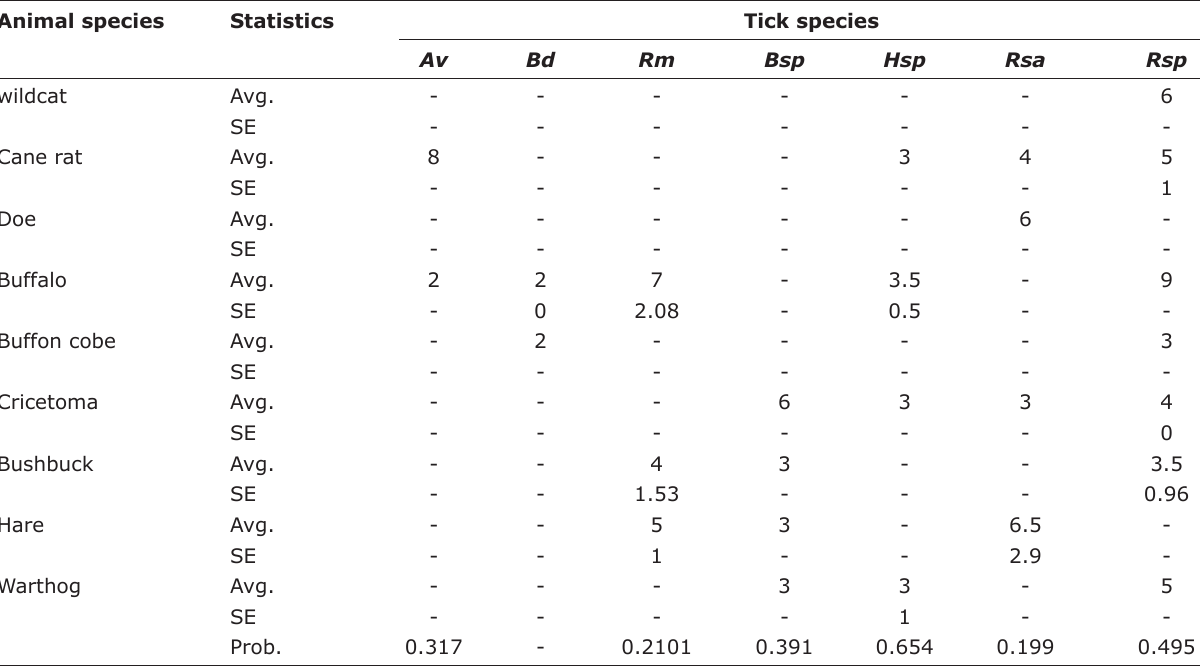
Table-4: Average number of ticks and standard error per tick and animal species. Animal species